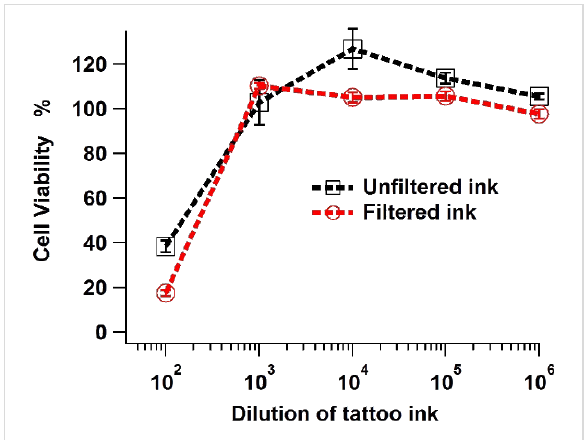
Figure 8: Cell viability of skin dermal fibroblasts incubated in diluted tattoo ink for seven days (filtered and unfiltered).